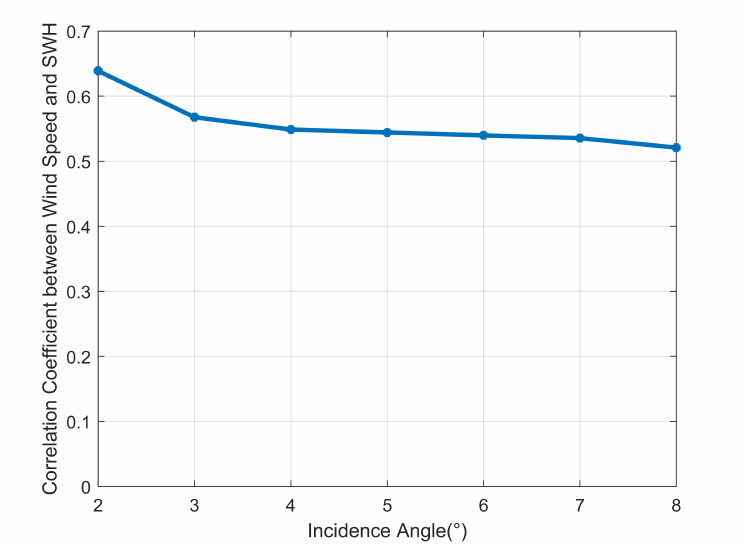
Figure 5. Correlation coefficients between wind speed and SWH at different incidence